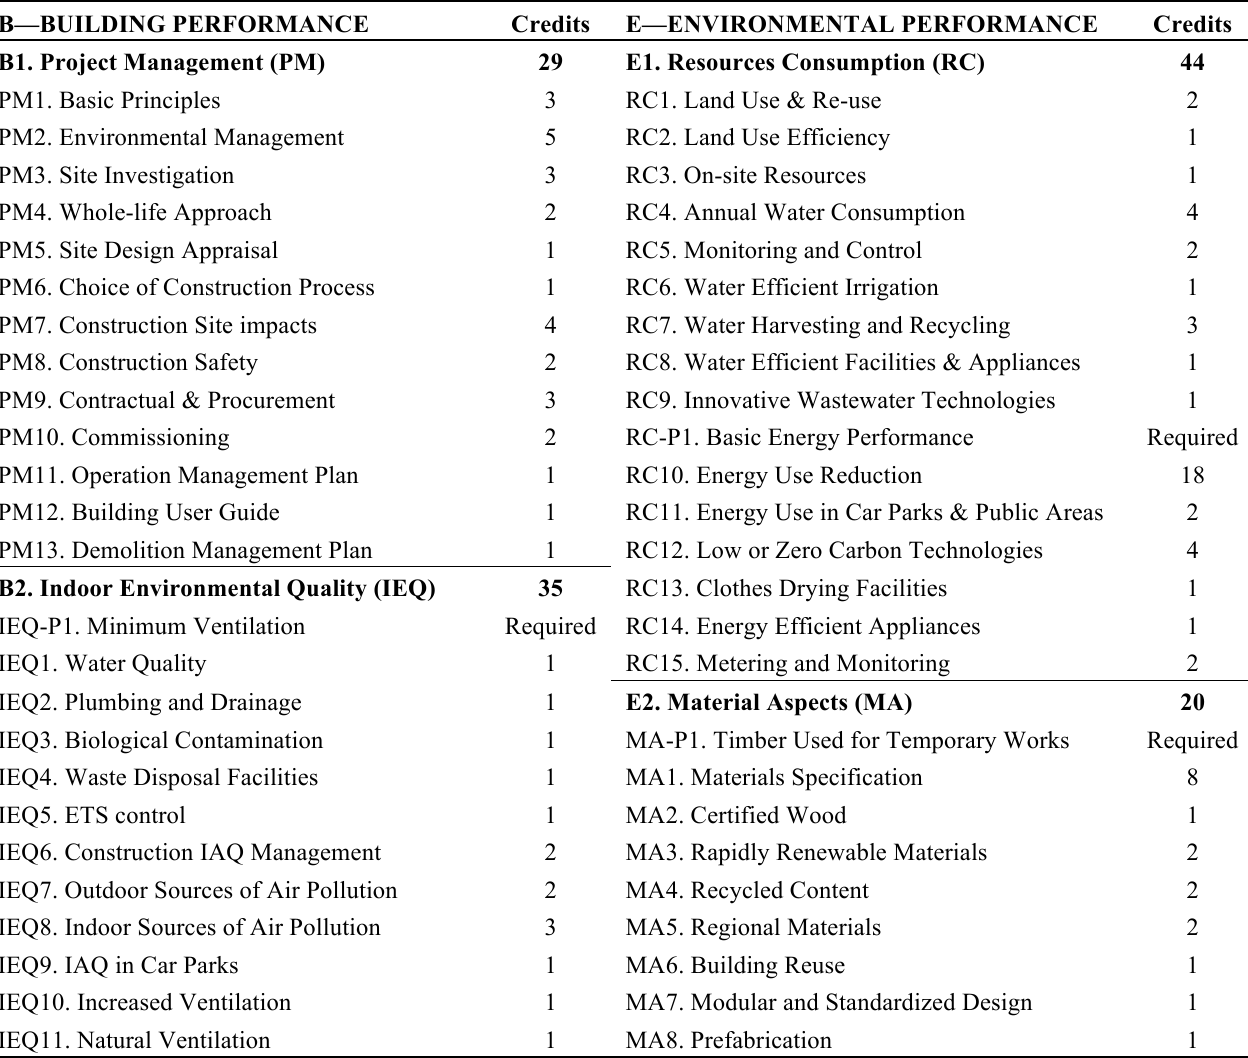
Table 1. TPSI’s system of assessment